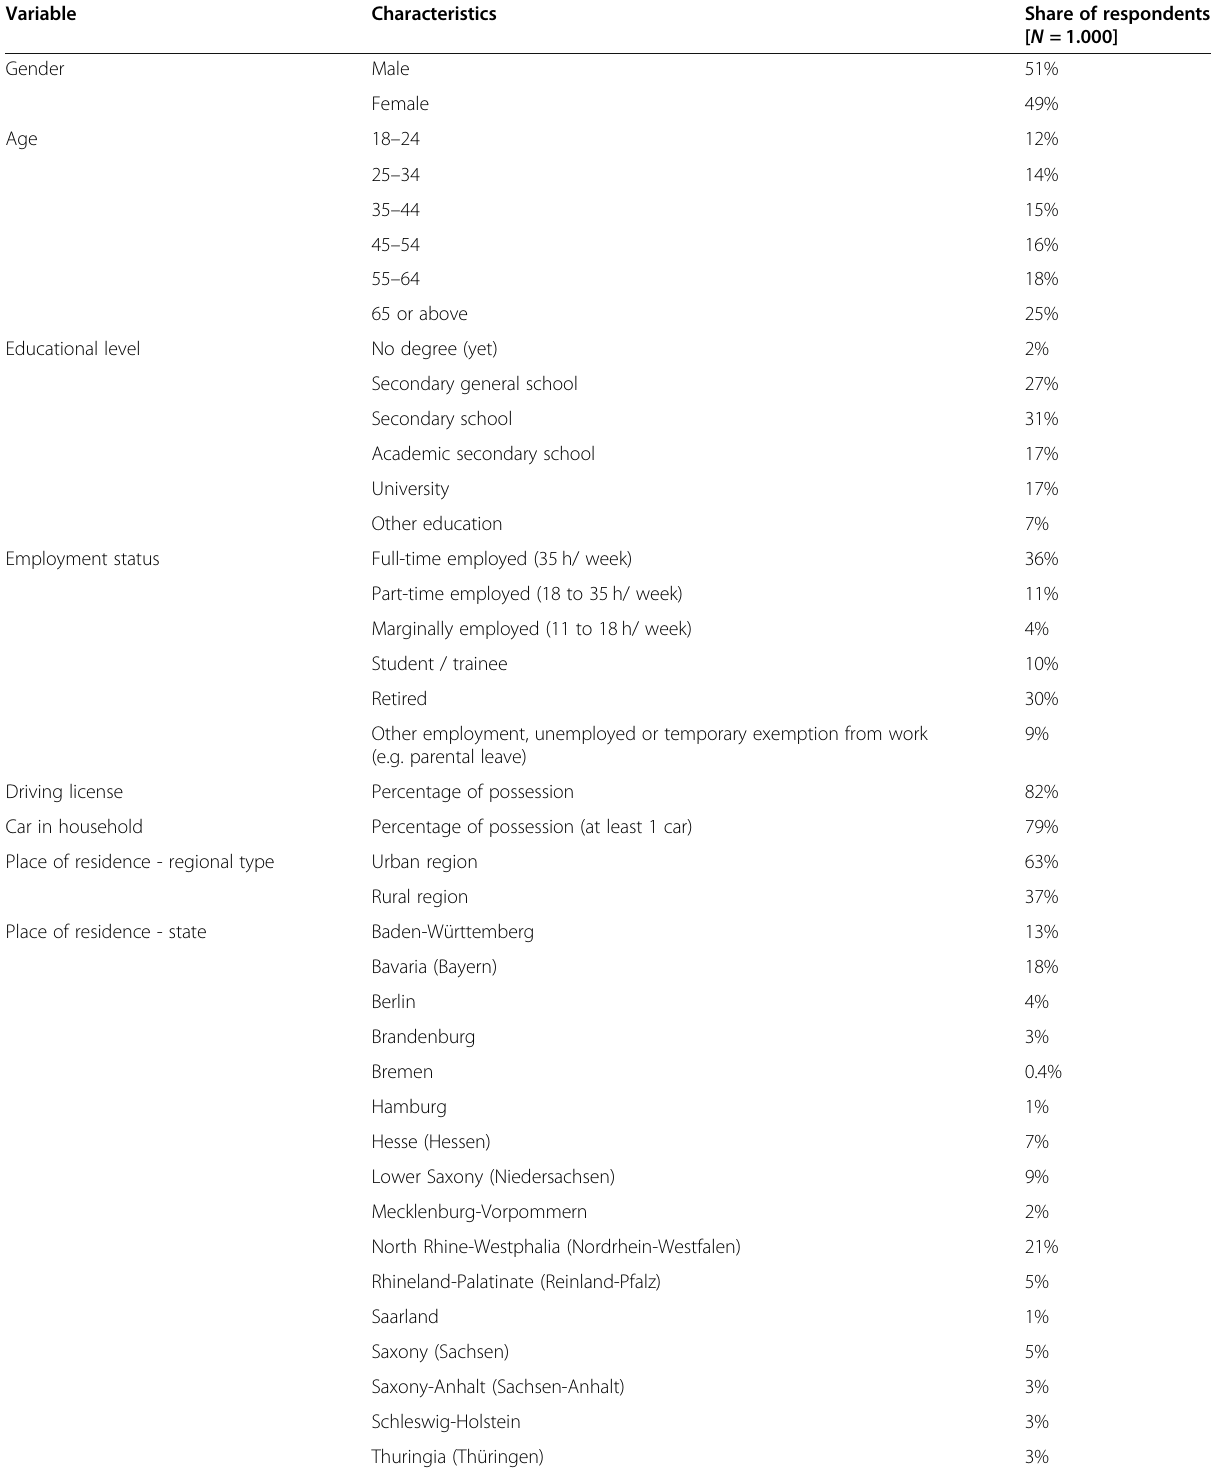
Table 1 Descriptive statistics of selected characteristics of the sample